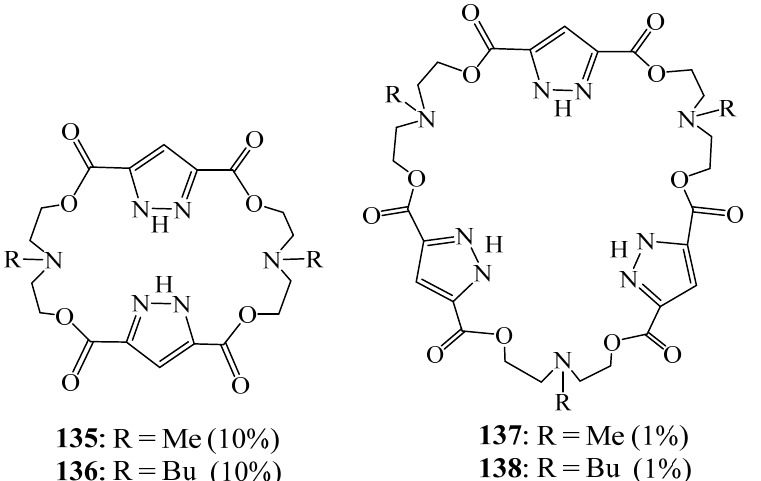
Figure 37. Macrocycles 135 − 138 containing two and three pyrazolic moieties. (Reprinted with per- mission from ref. [59]. Copyright 2011 American Chemical Societ).